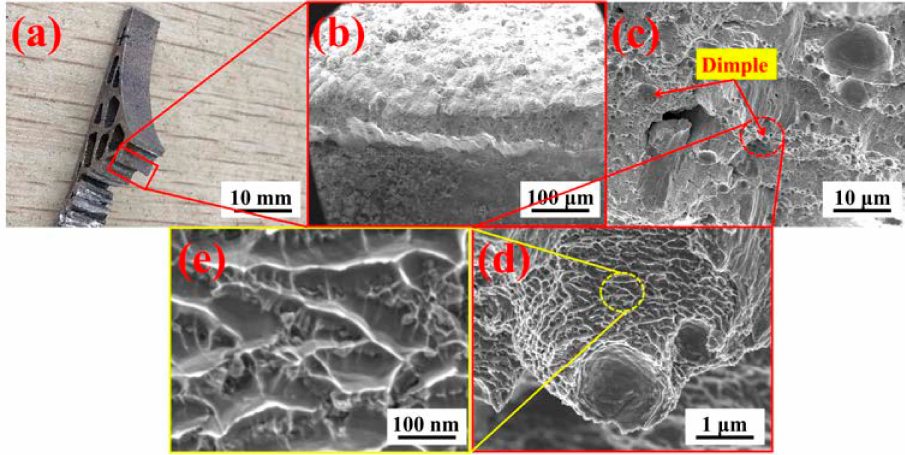
Figure 11. Photograph and SEM micrographs of fractured surfaces of the tree column structures-type AlSi10Mg alloy branches. ( a ) Photograph and ( b – e ) SEM micrographs. AlSi10Mg alloy branches. ( a ) Photograph and ( b – e ) SEM micrographs.